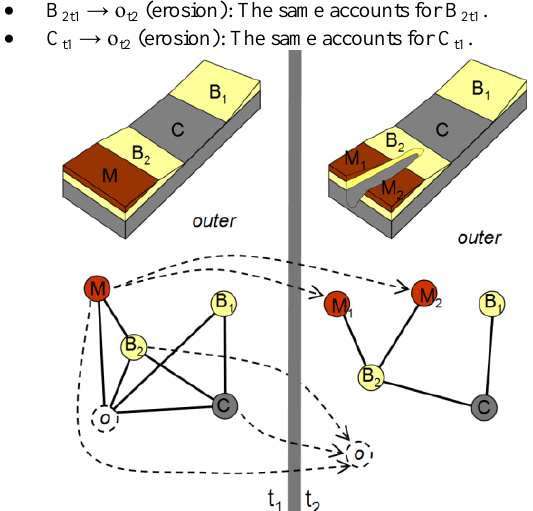
Figure 9. Representation of a landform by LandFormState at t 1 and t 2 and the change between these two points in time by Abstract_GeoProcesses (dashed arrows). DualStructure- Relations to the outer at t 1 have not been included for t 2 .